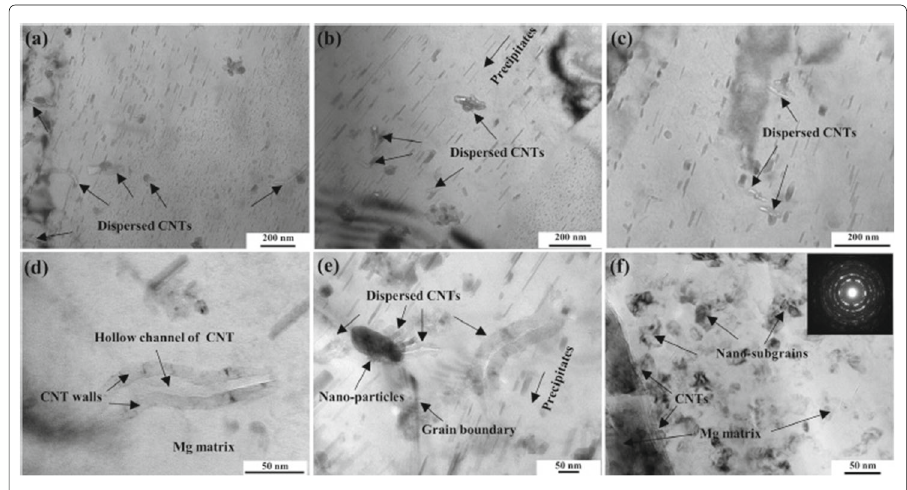
Fig. 11 TEM images of FSPed Mg-CNT MMC: ( a – c ) Dispersion of CNTs, ( d , e ) CNTs morphology in MMC, ( f ) nano sub grains next to CNT